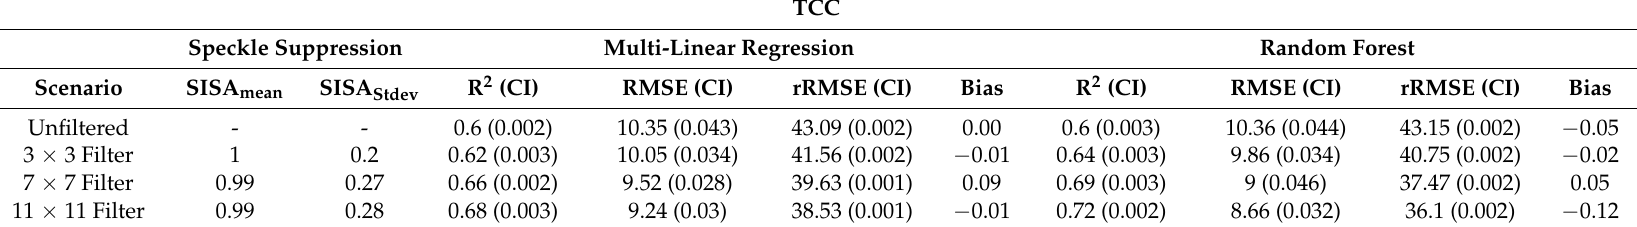
Table 2. The TCC and TCV results for the 2007/2008 Dry scenario, using different temporal filtering treatments and different models. The filter’s ability to preserve the image mean (i.e., SISA mean ) and suppress speckle (i.e., SISA Stdev ) are also represented. TCC Speckle Suppression Multi-Linear Regression Random